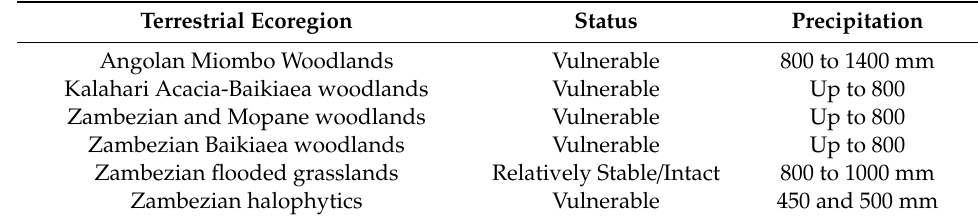
Table 3. Terrestrial ecoregions within the study area in the Okavango Basin of Angola, Namibia and Botswana, their conservation status and mean annual precipitation